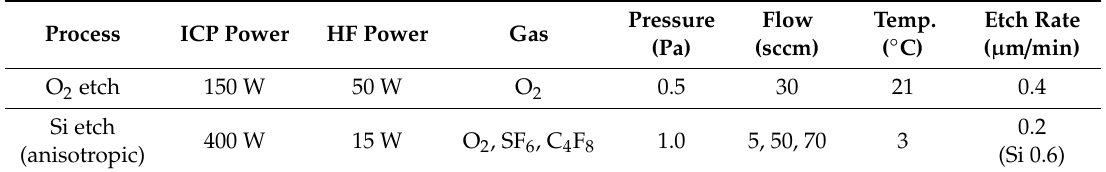
Table 3. Etching of the thiol polymer by RIE. Two typical RIE recipes used to remove or structure polymers (O 2 etch) and silicon (Si etch) were